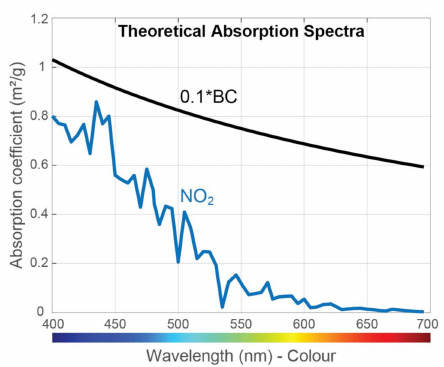
Figure 3. Theoretical light absorption intensity of Black Carbon (BC) together with the absorption potential of NO 2 across the visible spectrum.